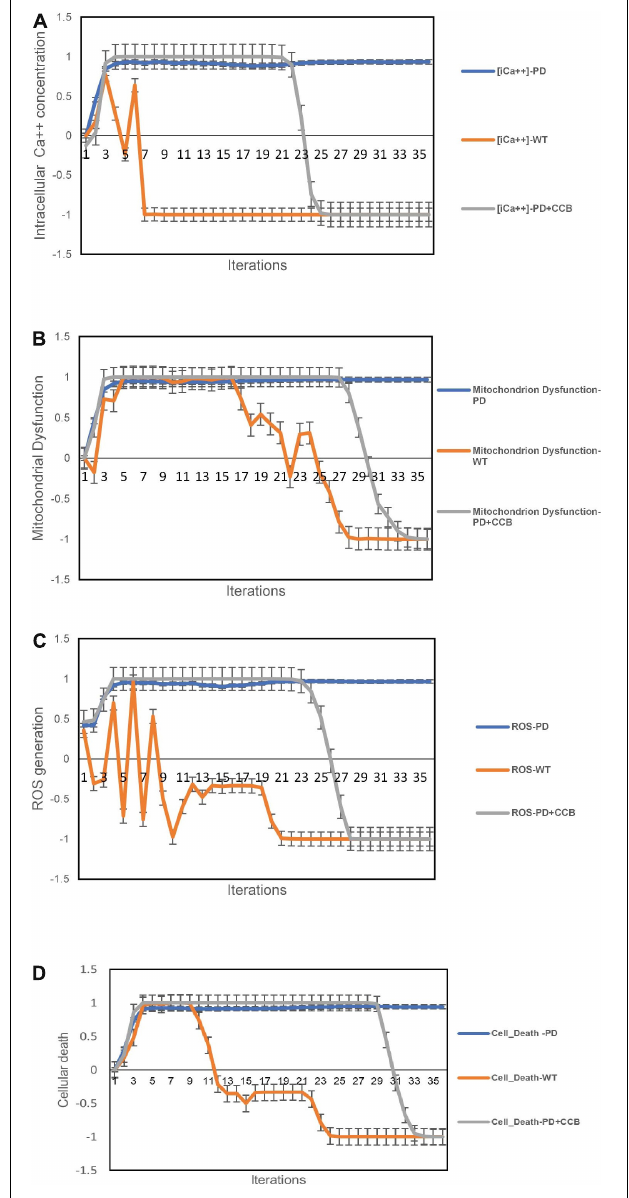
FIGURE 4 | Predicted effects of calcium channel blockade (CCB) (IOPD vs. WT simulations). (A) Effect of CCB on intracellular calcium concentration. (B) Effect of CCB on mitochondrial dysfunction. (C) Effect of CCB on Reactive Oxygen Species (ROS). (D) Effect of CCB on cell death. Data are representative of three independent simulation experiments; e rror bars indicate ±